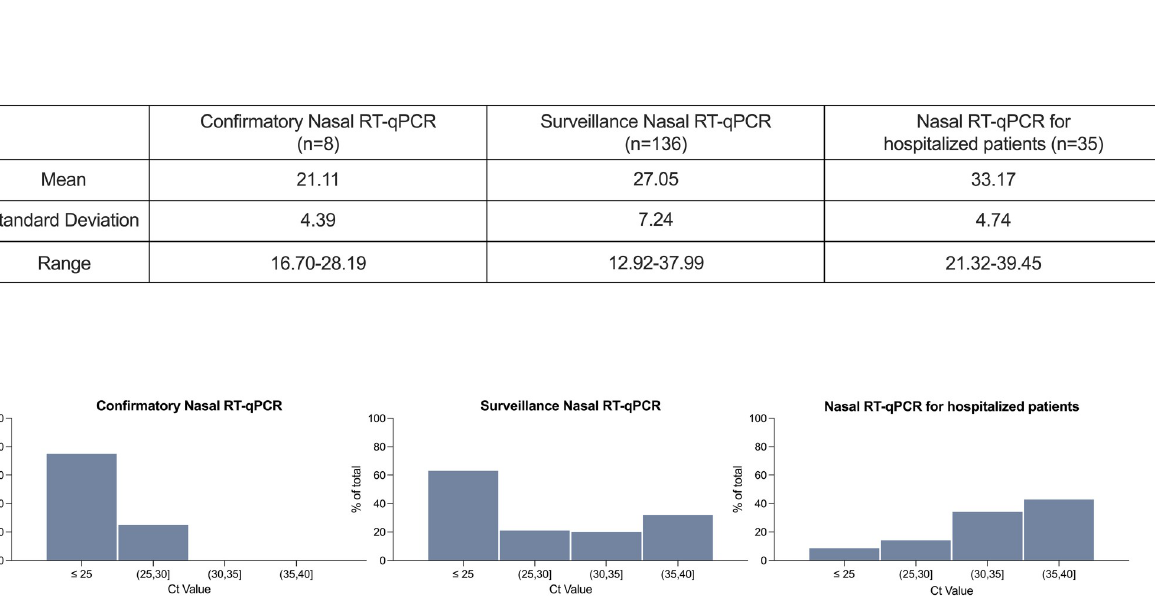
PLOS ONE | https://doi.org/10.1371/journal.pone.0264130 February 25,